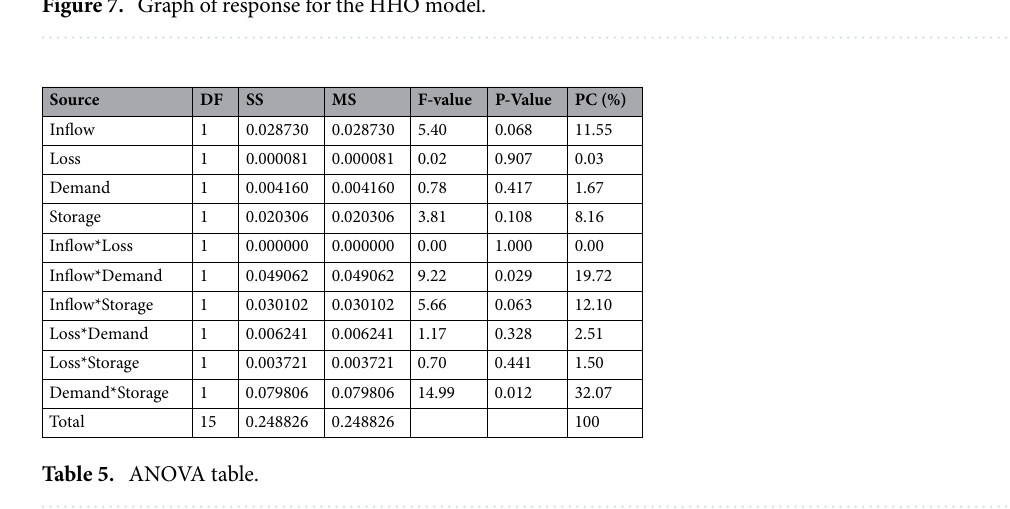
Figure 7. Graph of response for the HHO model.